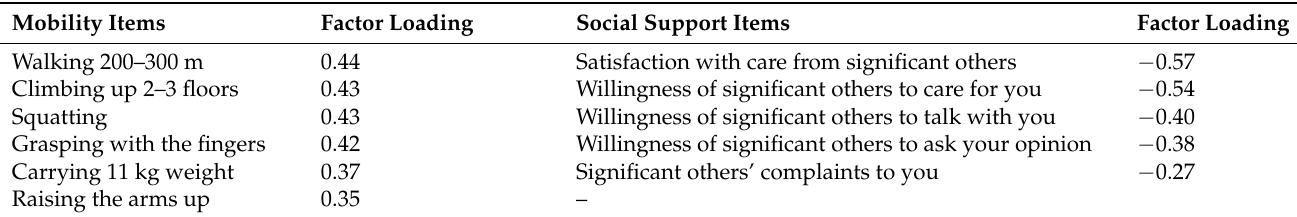
Table 2. Factor loading derived by reduced rank regression: using pre-SD mobility and social support